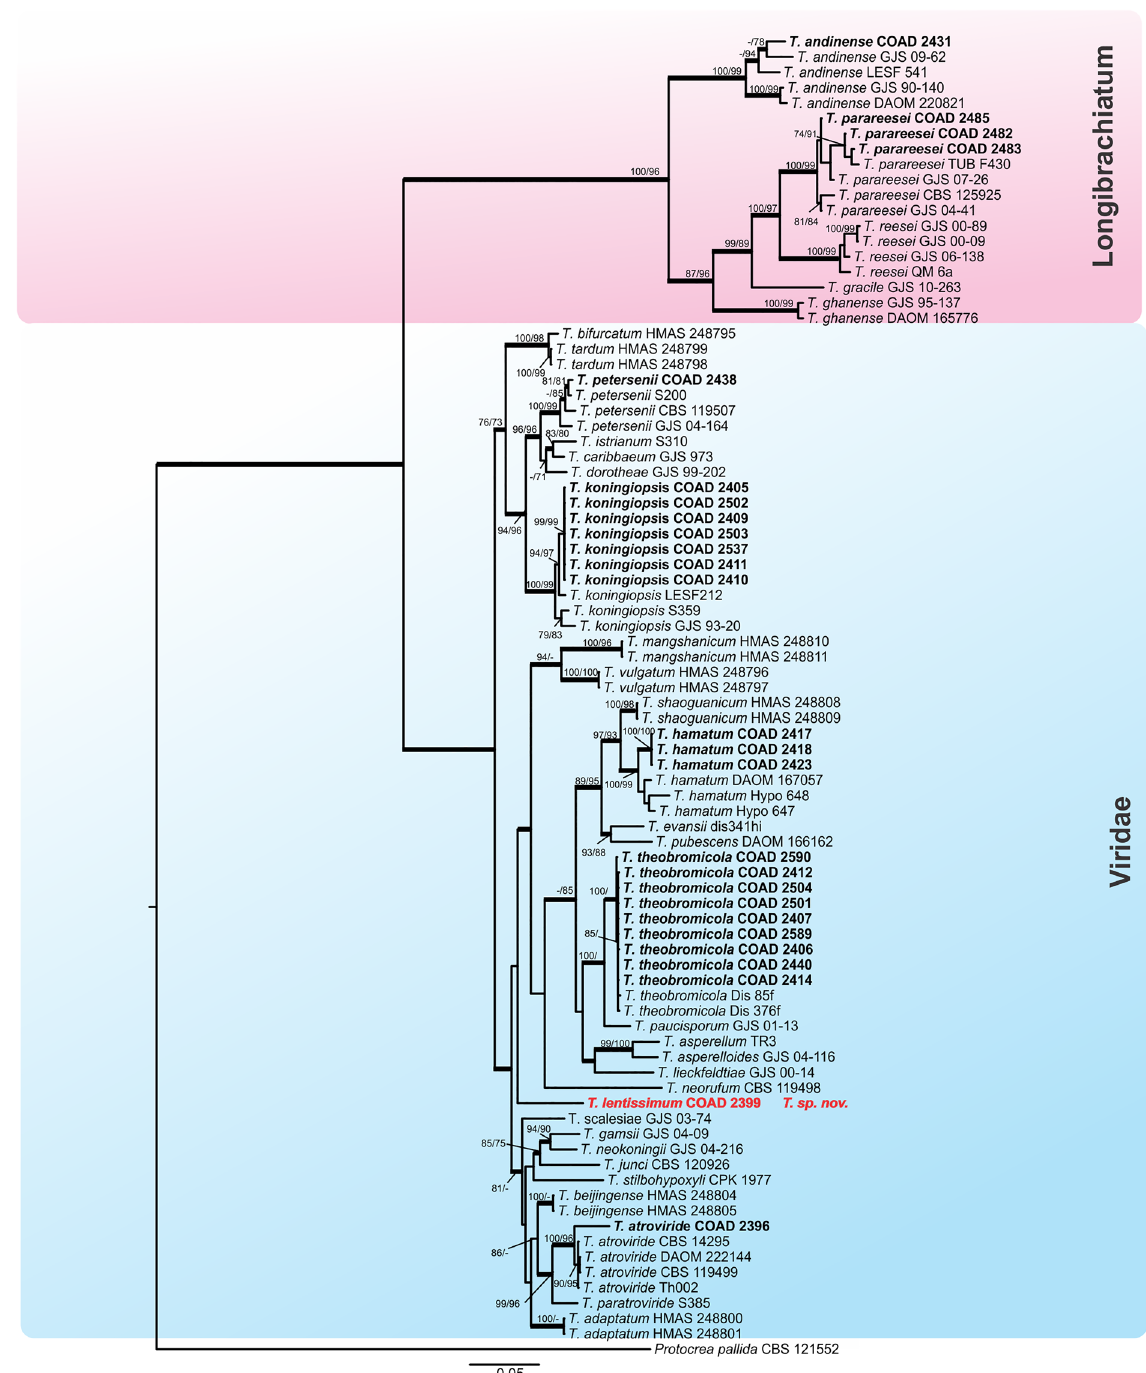
Figure 2. Bayesian phylogenetic tree of clades Longibrachiatum and Viride . The tree was based on a concatenated tef1 and rpb2 sequence dataset. Bootstrap values (≥ 70%) of the ML and MP analyses, as well as posterior probability scores (≥ 0.9) from a Bayesian analysis of the same dataset, are indicated at well supported nodes together with thickened branches. The isolates belonging to known species, obtained in this study, are in bold. Isolates of new species, described in this study, are in bold red. The tree was rooted with Protocrea pallida (CBS 121552). The phylogenetic tree was edited using Inkscape 1.0 (https ://inksc